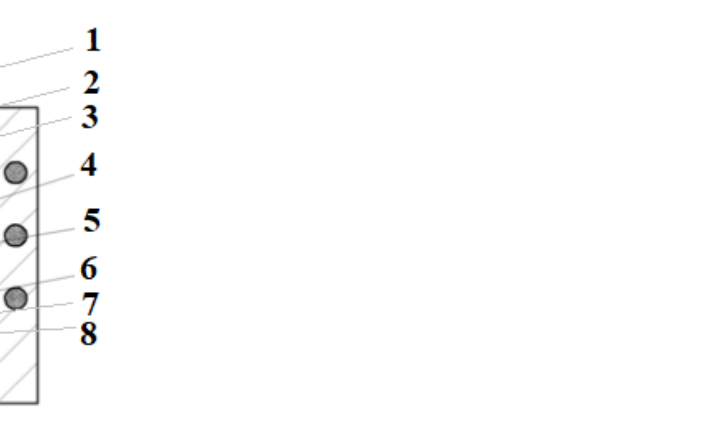
Figure 1. Schematic of cell with parallel electrodes for measuring the electrical conductivity: 1—Pt/Pt(Rh) thermocouple, 2—additive tube (alumina), 3—quartz container, 4—molybdenum electrodes, 5—BN-bar, 6—melt, 7—glass carbon crucible, 8—supporting guard crucible (alumina).